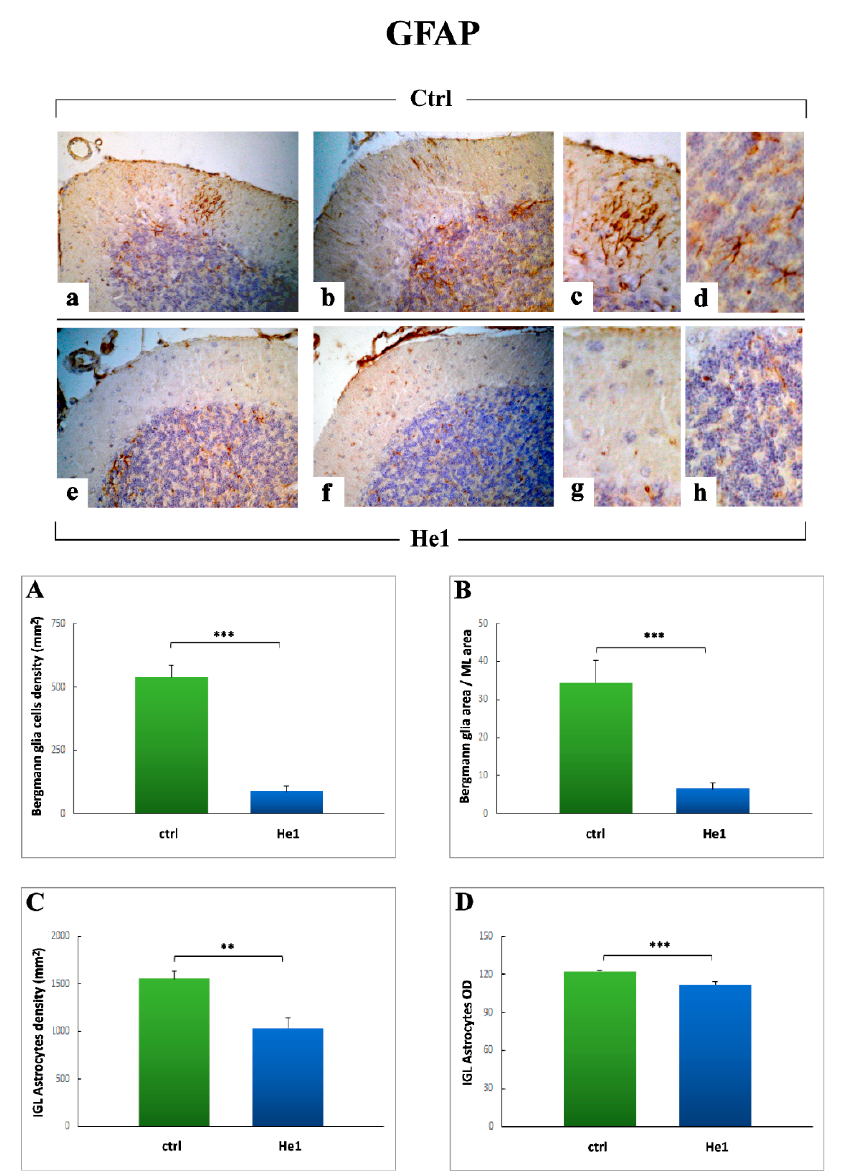
Figure 8. GFAP DAB-immunostaining reaction in untreated ( a – d ) and He1-treated mice ( e – h ). Light microscopy magnification: 40 × ( a , b , e , f ); 100 × ( c , d , g , h ). Panels ( A – D ) Histograms showing quantitative analyses of BG immunopositive cell density, ratio between GFAP-immunopositive area in the ML and whole ML area, IGL immunopositive astrocytes density and OD, respectively. p values calculated by unpaired Student’s t -test: ** p < 0.01, *** p < 0.001.